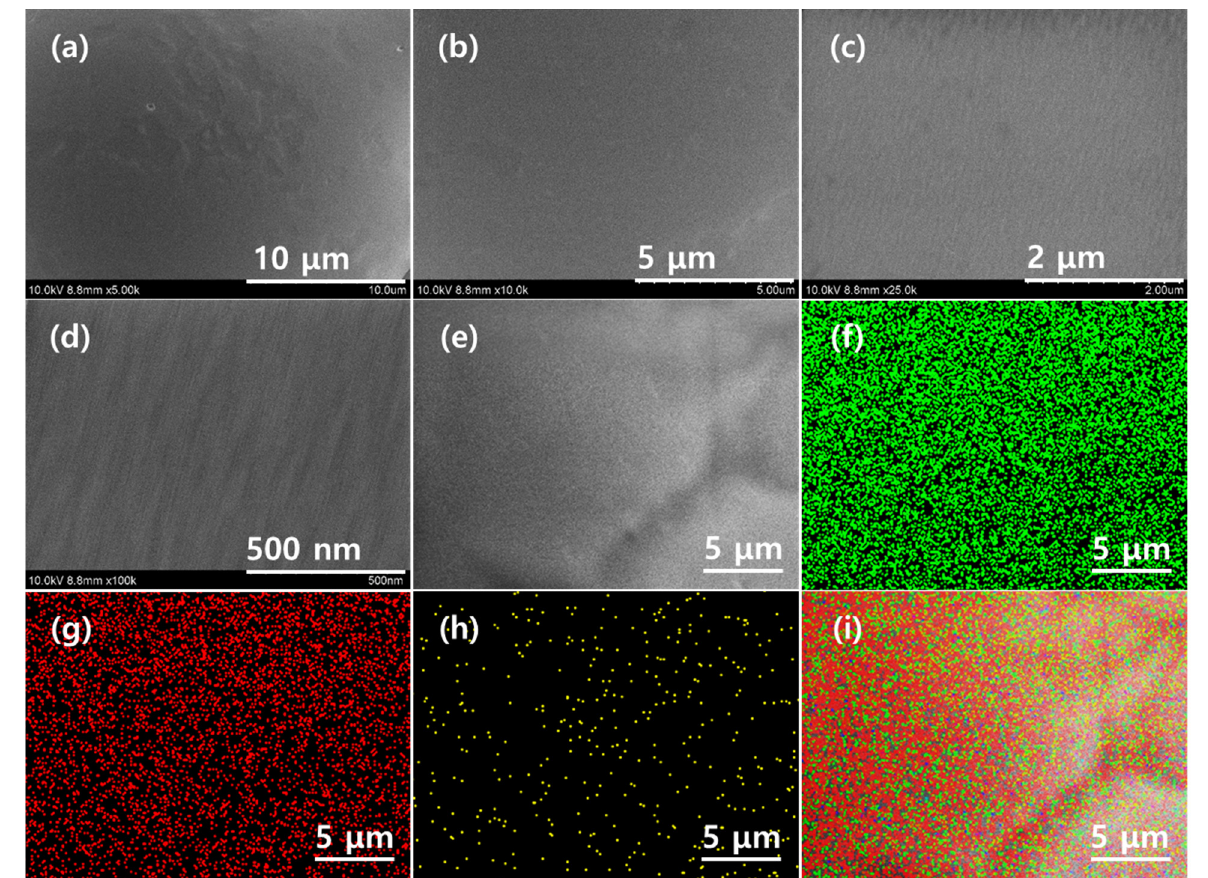
Figure 1. ( a – e ) FESEM images with different magnifications of the synthesized TC-CDs and the corresponding ( f ) carbon, ( g ) nitrogen, ( h ) oxygen, and ( i ) overlapping elemental maps of the presented elements.